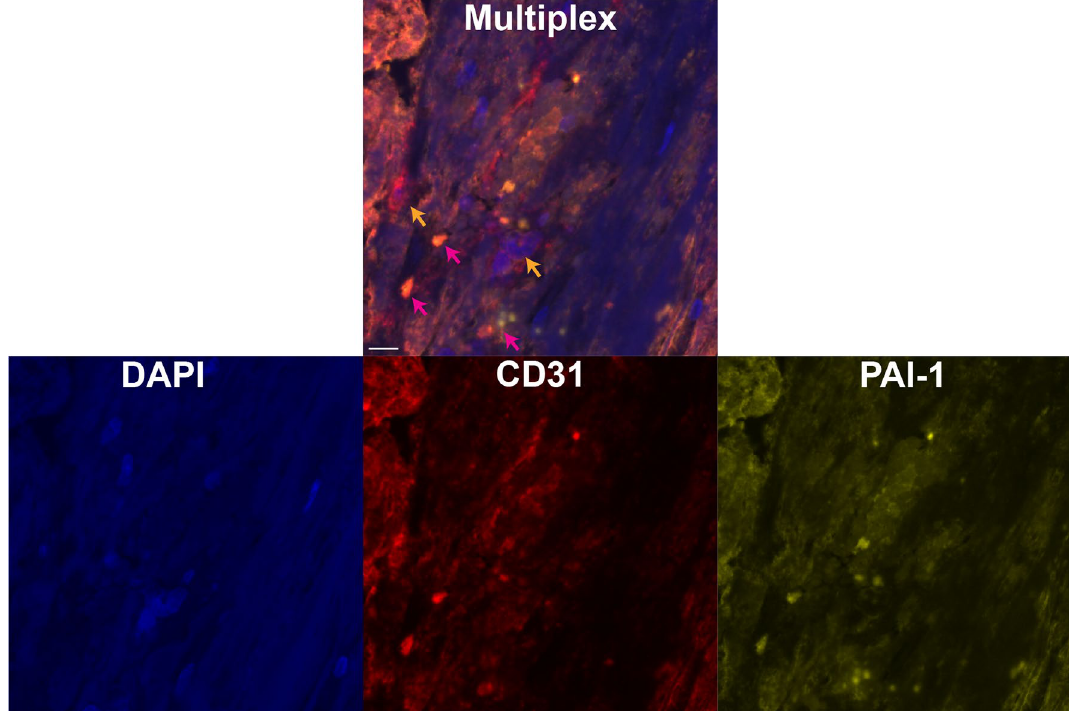
Figure 6. (Top) Representative multiplexed thrombus image indicating nucleated cells assessed with DAPI (blue), PAI-1 (yellow) and CD31 (red). Orange arrows indicate representative locations for cells associated with revascularization (co-expression of DAPI and CD31). Magenta arrows indicate representative areas for co-expression of PAI-1 and CD31. The white bar is a 10 µm distance (40 × magnification). Multiplex IHC staining was performed on 5 micron FFPE tissue sections using the Opal 7-Color Manual IHC Kit (NEL861001KT; Akoya Biosciences) following the manufacturer instructions. All slides were counterstained with Spectral DAPI (1:10, Akoya Biosciences) nuclear stain and mounted with Slowfade Diamond Antifade mountant (Thermo Fisher Scientific). The slides were then scanned using the Vectra Polaris whole slides scanner (Akoya Biosciences), the regions of interest were selected using the Phenochart software (Akoya Biosciences) and analyzed using Inform software (Akoya Biosciences). Antibody information can be found in Supplemental Table 2. The individual channels for each components are shown in the lower three panels.